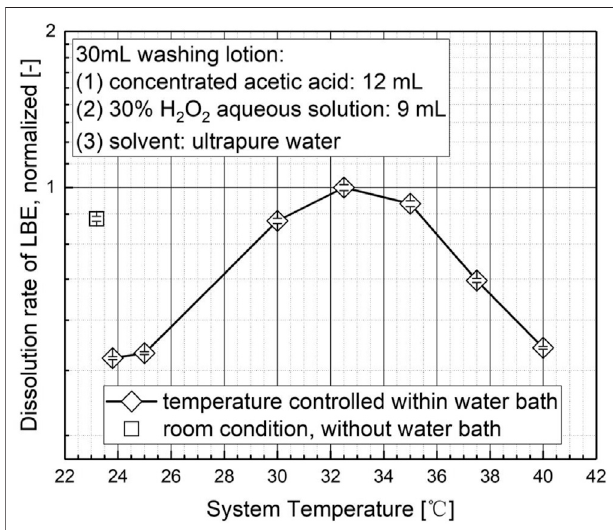
FIGURE 4 | The relationship between system temperature and the dissolution rate of the lead – bismuth alloy